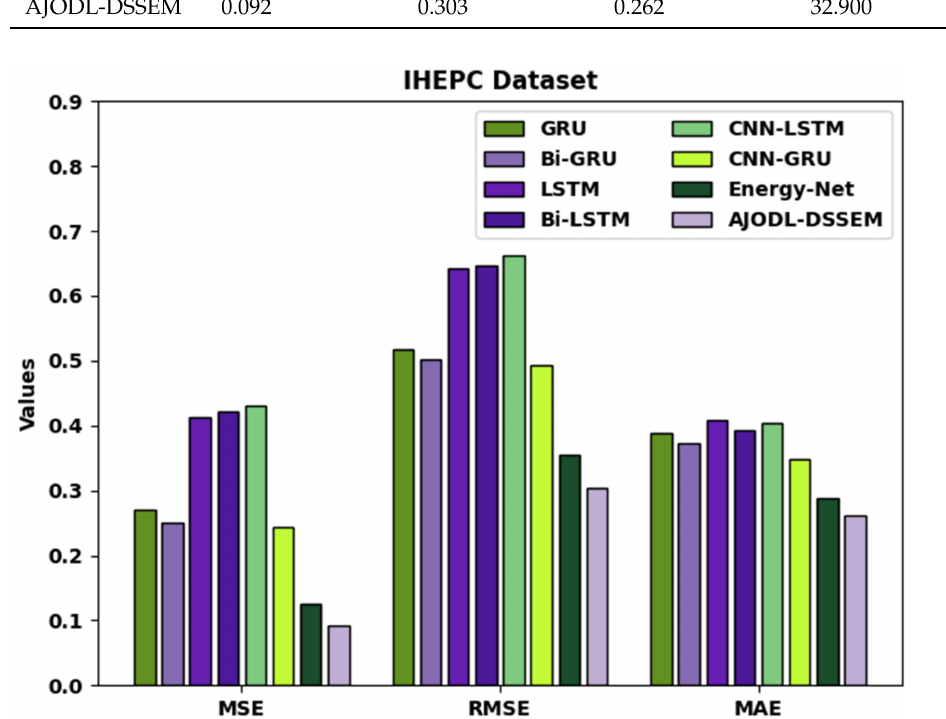
Figure 8. Comparative analysis of AJODL-DSSEM algorithm under IHEPC